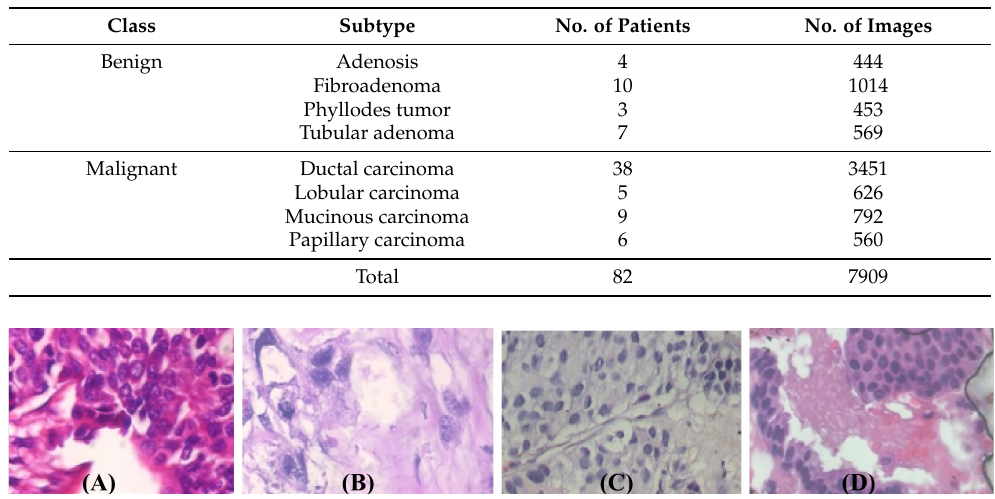
Figure 10. Sample of malignant subtypes: ( A ) ductal carcinoma; ( B ) lobular carcinoma; ( C ) mucinous carcinoma; ( D ) papillary carcinoma.